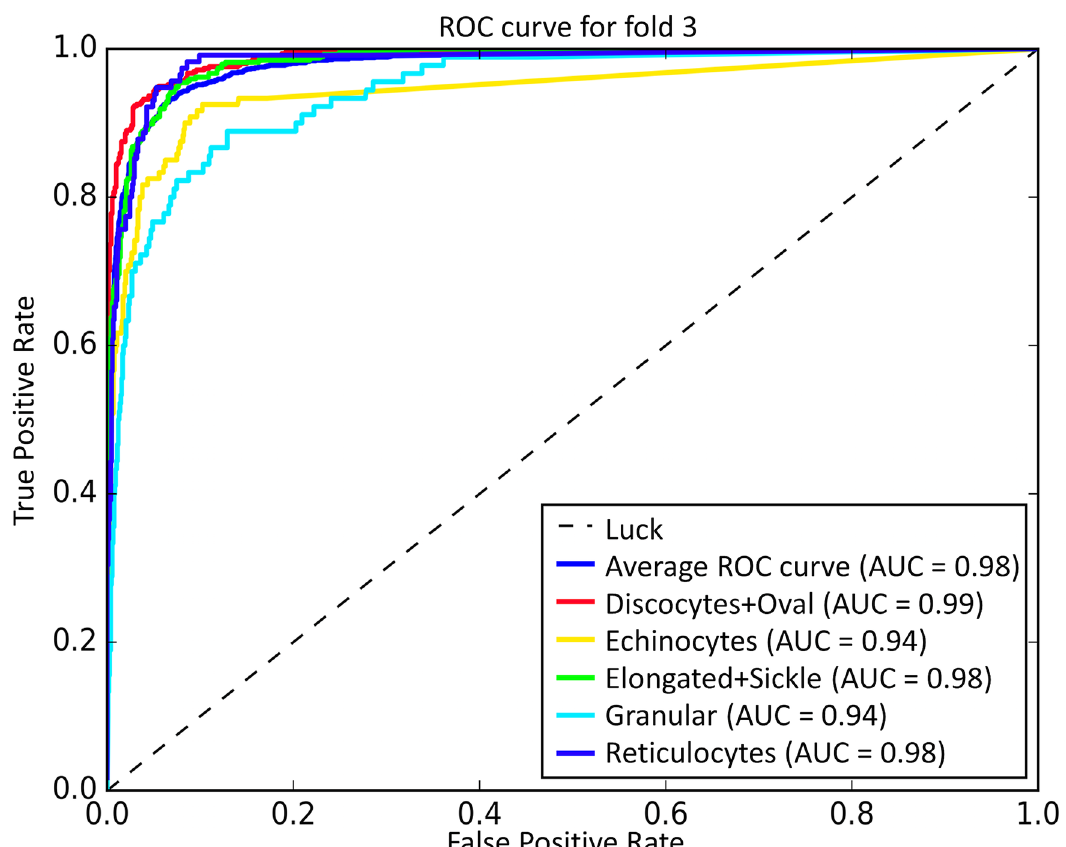
Fig 12. ROC-AUC result for coarse 5 types of RBC classification based on “Exp_II” dataset by 5-fold cross validation.